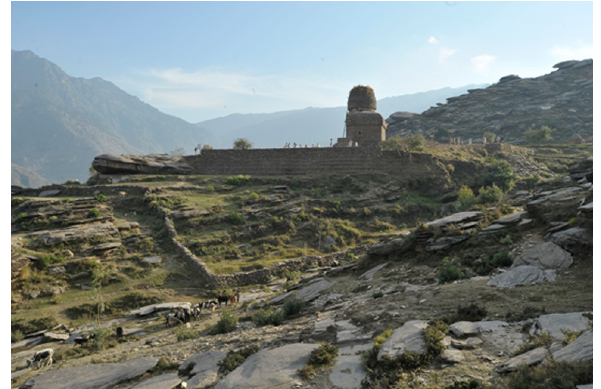
Figure 3 . The terrace of Gumbat (GBK I). View from N (2011).